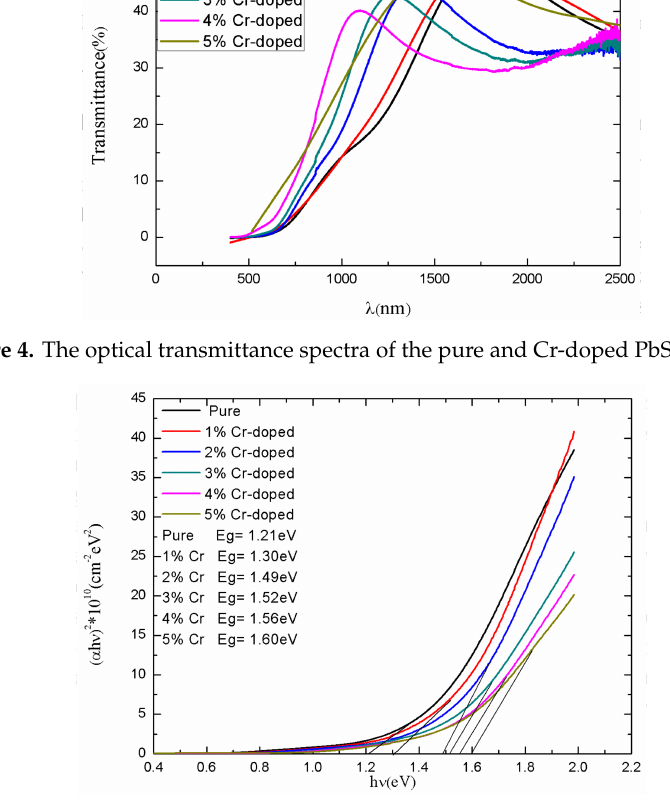
Figure 5. Optical band-gap spectra of the samples as a function of Cr doping.